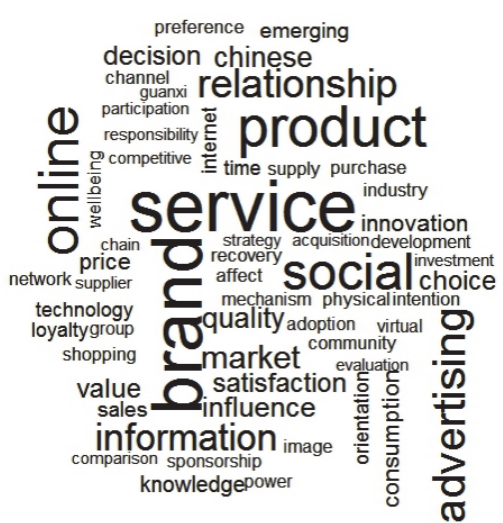
<Figure 5> Top 50 Marketing Topics in Zone HS (Hong Kong, Macau, Singapore, Taiwan)